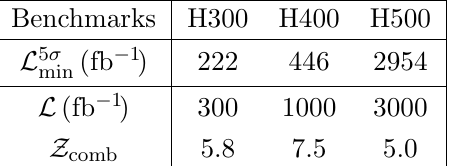
at the LHC (14 comb